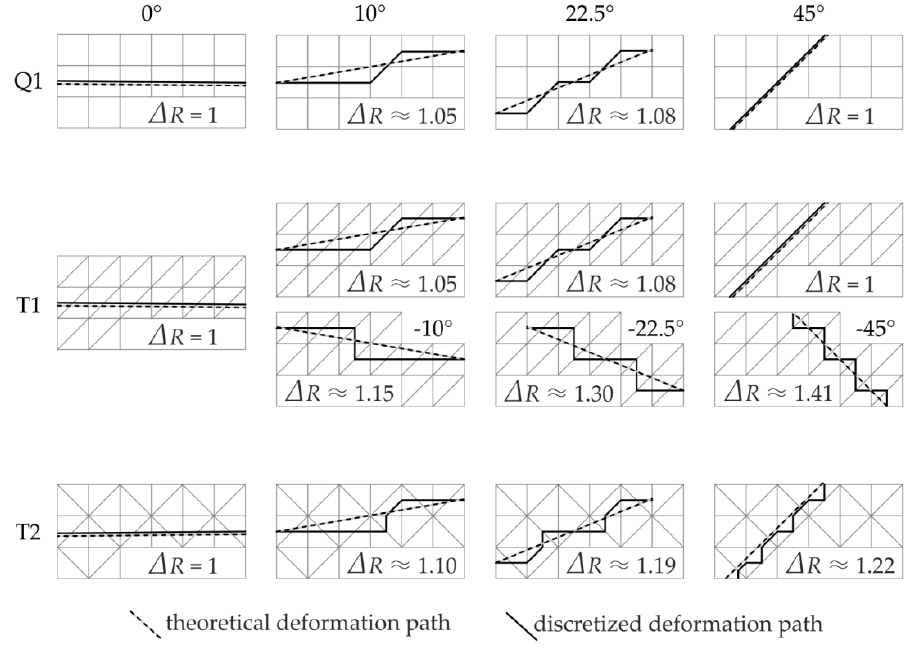
Figure 8. Discretized (solid line) and theoretical (dashed) path of a deformation feature, here shown for two grids with different arrangements of triangles.